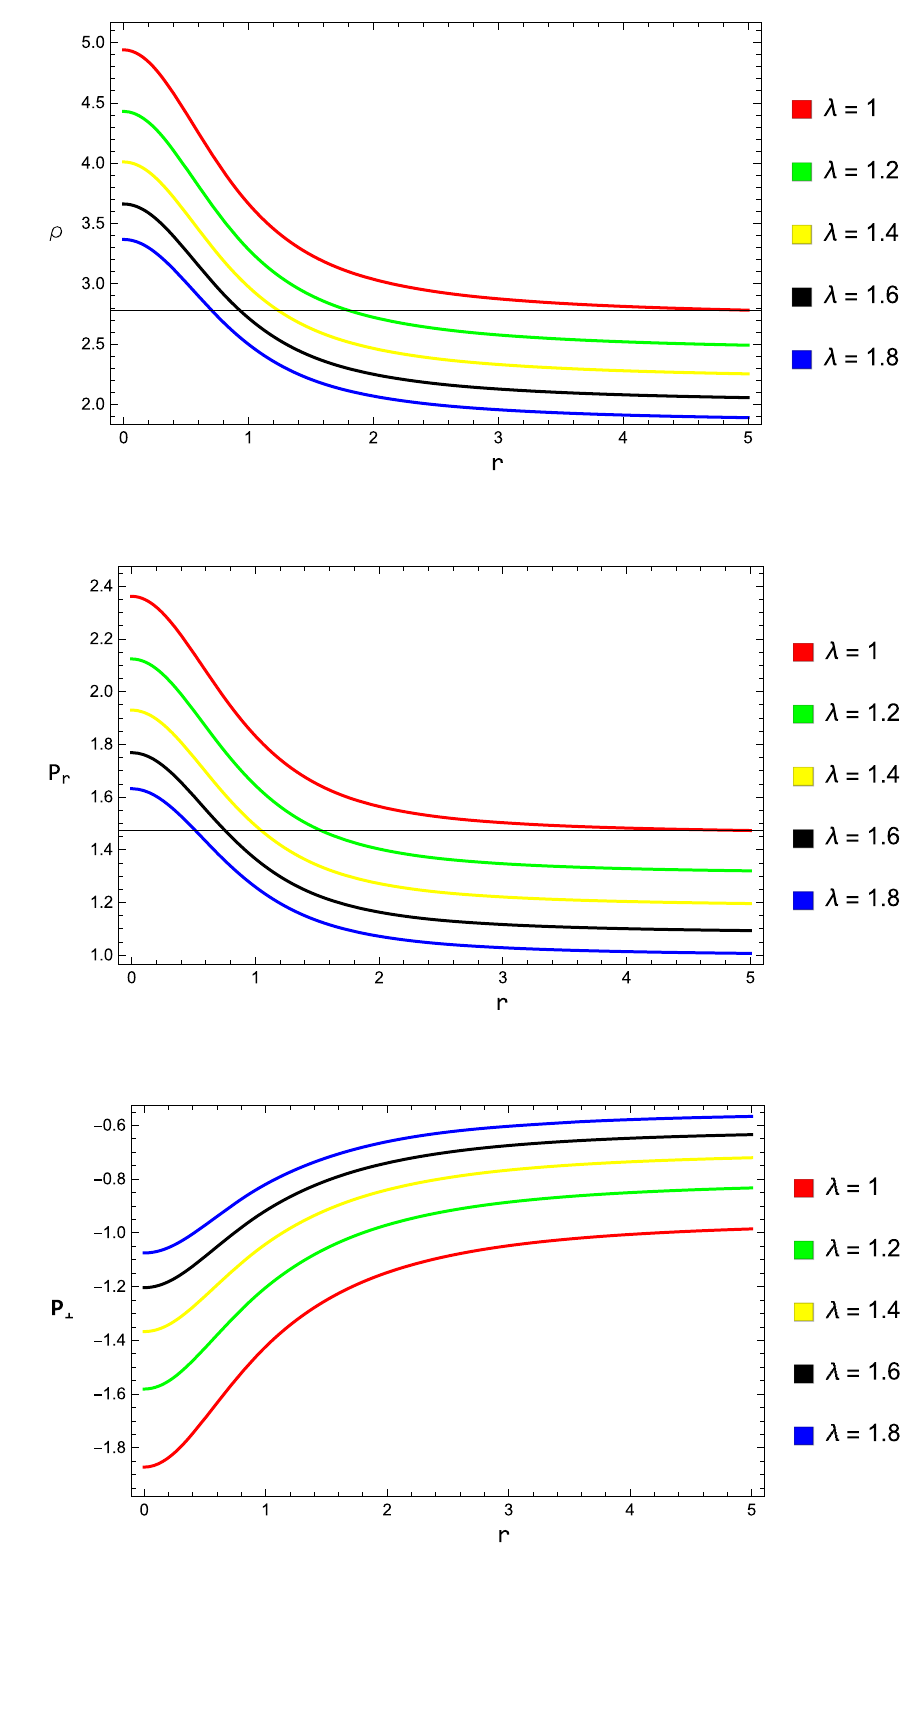
Fig. 5 The variation of ρ with respect to r for the various values of λ and h 2 ( t ) = 1